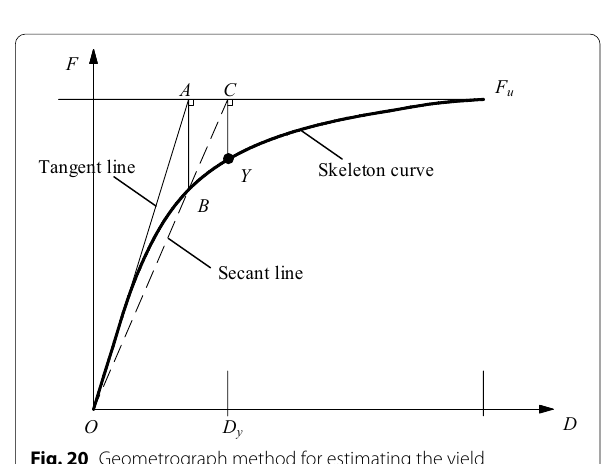
Fig. 20 Geometrograph method for estimating the yield displacement ( D y ).